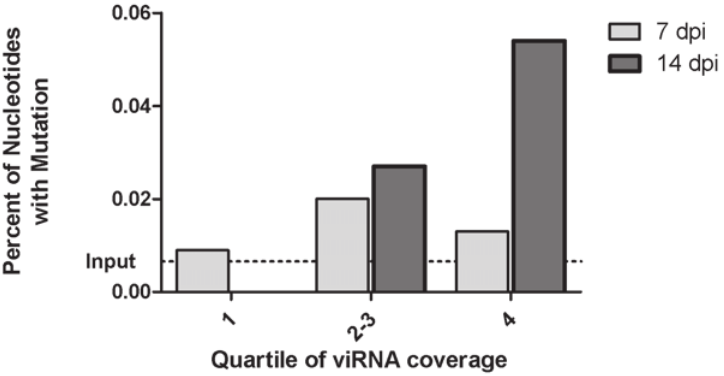
Figure 5. Intense Targeting of WNV Genome Is Associated with High Mutational Diversity. viRNA coverage intensity was classified according to quartiles. Interquartile ranges (min, max) at 7 and 14 days were 1–6 (0, 64) and 3–11 (0, 120), respectively. The total number of nucleotides sequenced in each coverage class was 10,225, 5,062 and 7,475 at 7 dpi and 5,990, 7,442 and 7,438 at 14 dpi. Statistical significance was determined by chi squared test for trend. A significant association between viRNA coverage was detected at 14 dpi (p=0.0393) but not at 7 dpi (p=0.8107).